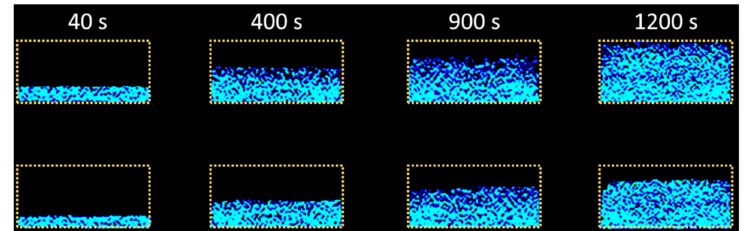
Figure 5. Evolution over time of the water uptake in the uncoated Lecce stone specimen (NT) (APL 16) (top), and the N215 coated specimen (APL 6) (bottom) monitored by MRIsorp procedure. The capillary water absorption for the coated specimen was carried out through the uncoated face.